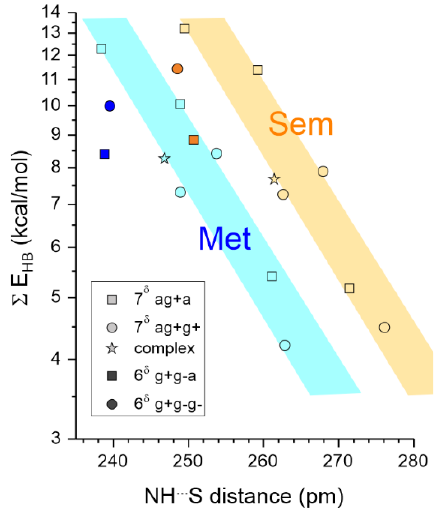
Figure 5. Semi-log plot of the stabilization energy Σ E HB due to the NH · · · S H-bonds 5SEE (Tables S3 and S4) against the NH···S distance theoretically found for the 7 δ and 6 δ H-bonds (light and yellow symbols resp.) in the 5-7 δ g+/g − -7 L , 5-7 δ /5 a - π and 6 δ - π g+ -10 backbone conformations of the Ac-Sem-Met-Phe-NH 2 dipeptides, with anti and gauche orientations of the Sem-Phe terminal dihedral χ 3 (square and disk symbols resp.) together with the intermolecular MAA···S-SeMe 2 complexes (stars) According to a previous NBO study of amide···amide interactions [29], in such plots the points aligned on the same trend illustrate comparable H-bond efficiency of the geometrical approach and enable to assess frustration or enhancement of the H-bond by its environment (see details in text).